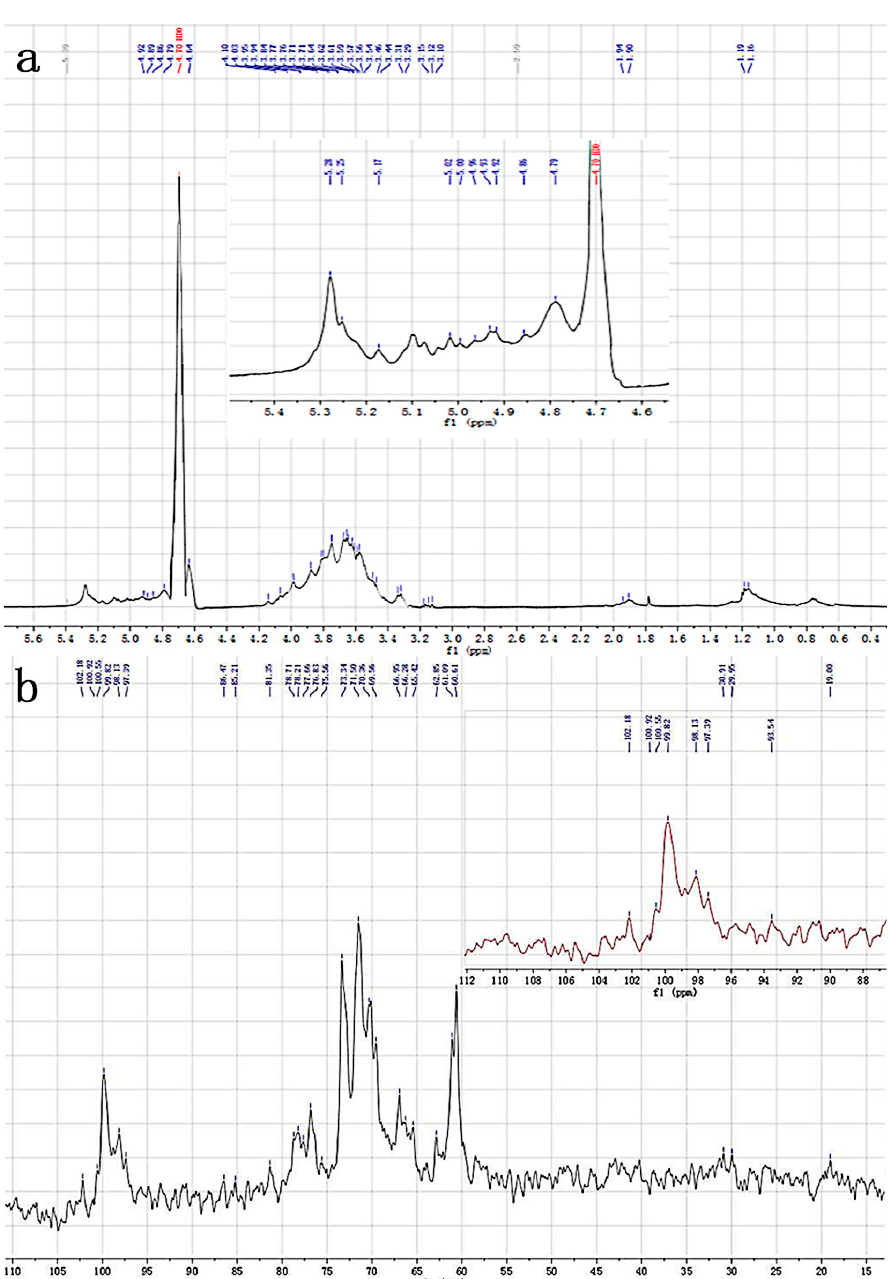
Figure 5. 1 H-nuclear magnetic resonance (NMR) ( a ) and 13 C-nuclear magnetic resonance (NMR) ( b ) spectra of M2.